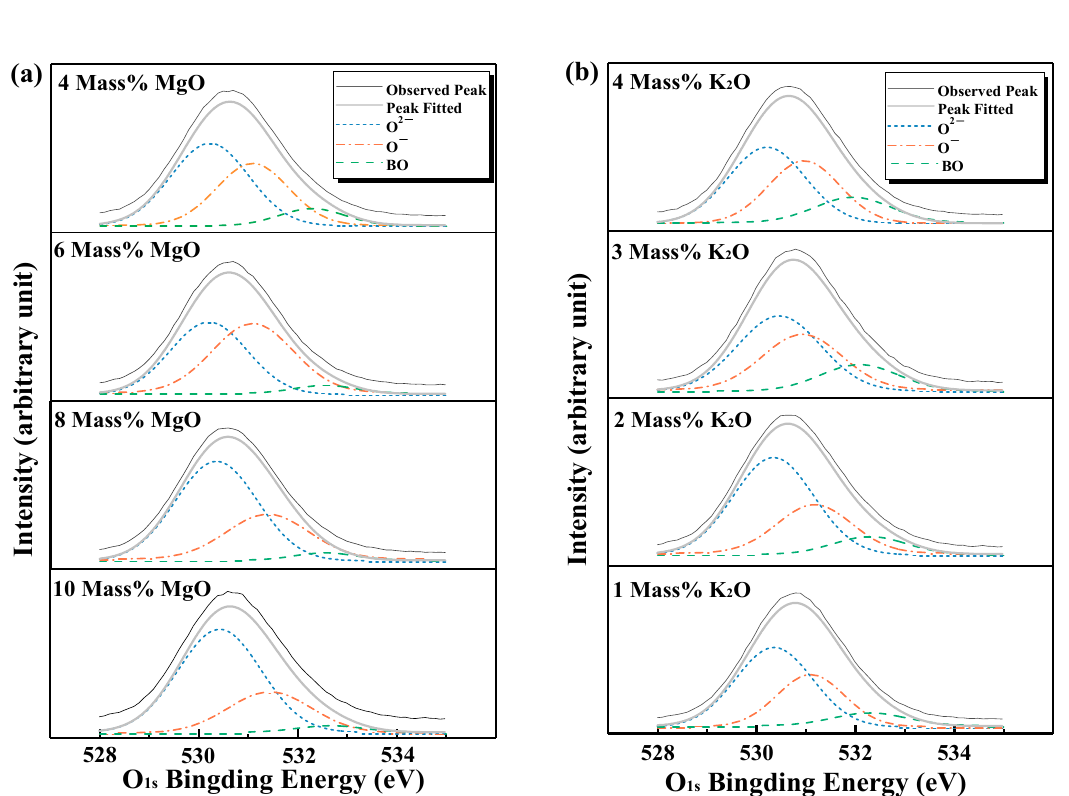
Figure 8. The O 1s XPS spectra for SiO 2 –CaO–25 mass% Al 2 O 3 –8 mass% MgO–MnO–K 2 O slag as function of binding energy ( a ) with varying MgO content; ( b ) with varying K 2 O content; BO is Bridging oxygen.